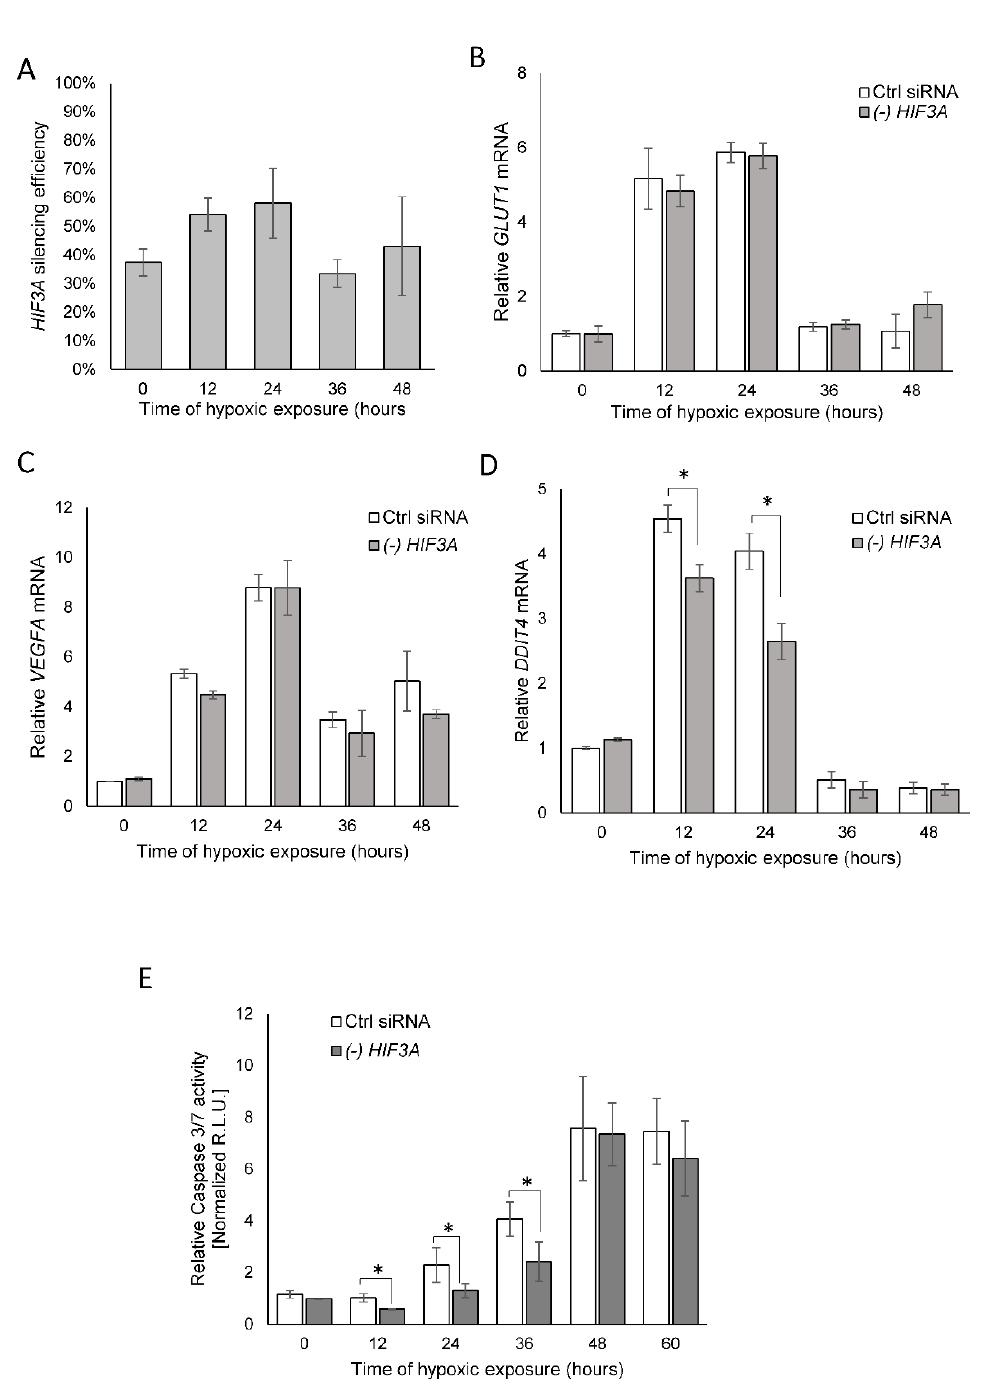
Figure 5: HIF-3α contributes to hypoxia-related elevated caspase 3 levels in HUVECs. ( A ) The silencing efficiency of HIF3A in hypoxia exposed HUVECs. Cells were transfected with siRNA against the HIF3A or control siRNA and exposed to hypoxia for the time periods specified and total RNA lysates were collected. HIF3A mRNA levels were quantified by qRT-PCR and normalized to TBP and 18S rRNA levels and expressed as a percentage of control siRNA transfected samples. Data represent the mean ± SD of two independent experiments (3 replicates each). * P < 0.05 was considered significant. ( B ) HIF3A knockdown does not affect hypoxia-induced expression of GLUT1 and ( C ) VEGFA , but does reduce ( D ) DDIT3 mRNA levels in hypoxia exposed HUVECs. ( E ) The caspase 3/7 activity was moni- tored by luminescence and expressed in Relative Light Units (R.L.U.). HUVECs with HIF3A knockdown or transfected with control siRNA for each time point of exposure to hypoxia were seeded in six technical replicates, and the experiments were repeated three times. Error bars represent standard deviations, *P < 0.05 was considered significant. The raw data are presented in Supplementary data